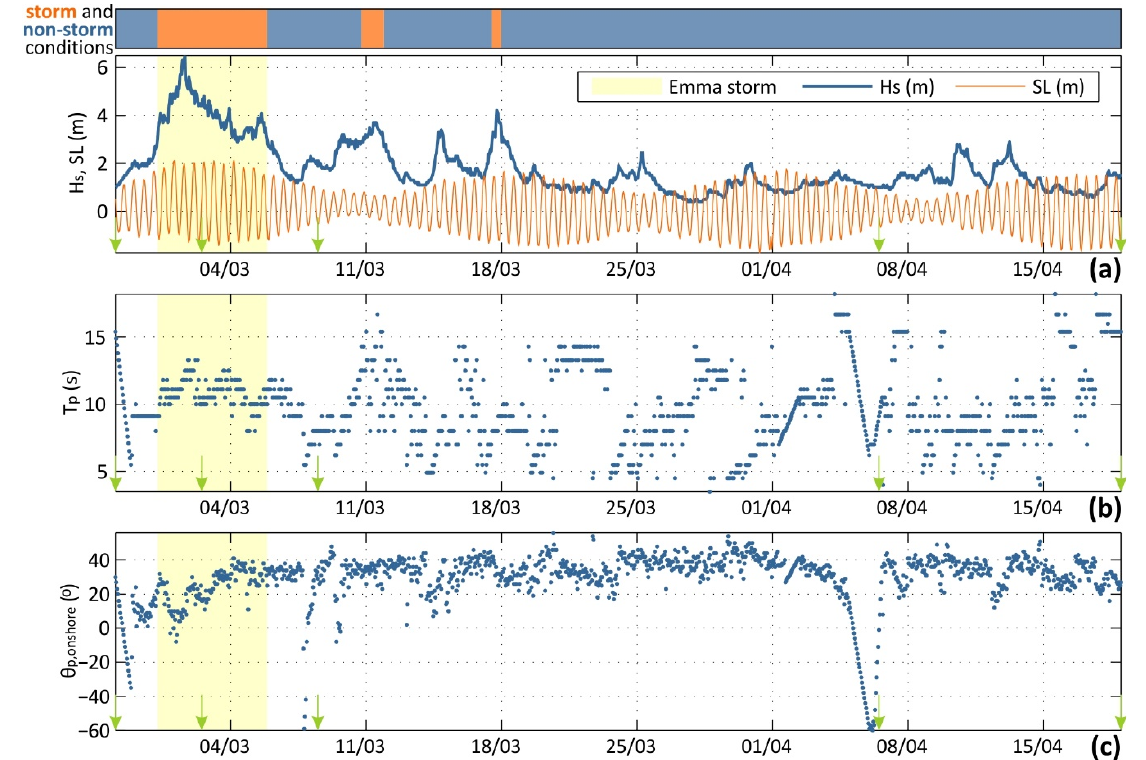
Figure 2. Time-series of significant wave height (H s ) and Sea Level (SL) ( a ), wave peak period (T p ; b ) and onshore wave direction ( θ p,onshore , with positive values denoting waves directed toward the inlet; c ). Wave data were collected from the Faro buoy (located at a depth of 93 m; Figure 1). Sea levels refer to surge levels (Huelva tide gauge) and astronomical tides for Faro. The yellow-shaded area on the plots denotes the incidence of Emma storm (28 February–5 March), green arrows show the dates of profile measurement and identified storm and non-storm conditions are marked (orange and blue, respectively) on the timeline above ( a